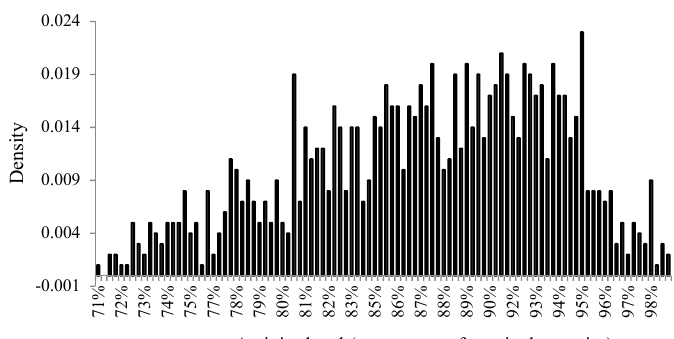
Figure 8. The probability density distribution of the activity level of petrochemical plant (source: authors calculation, using Crystal Ball software.